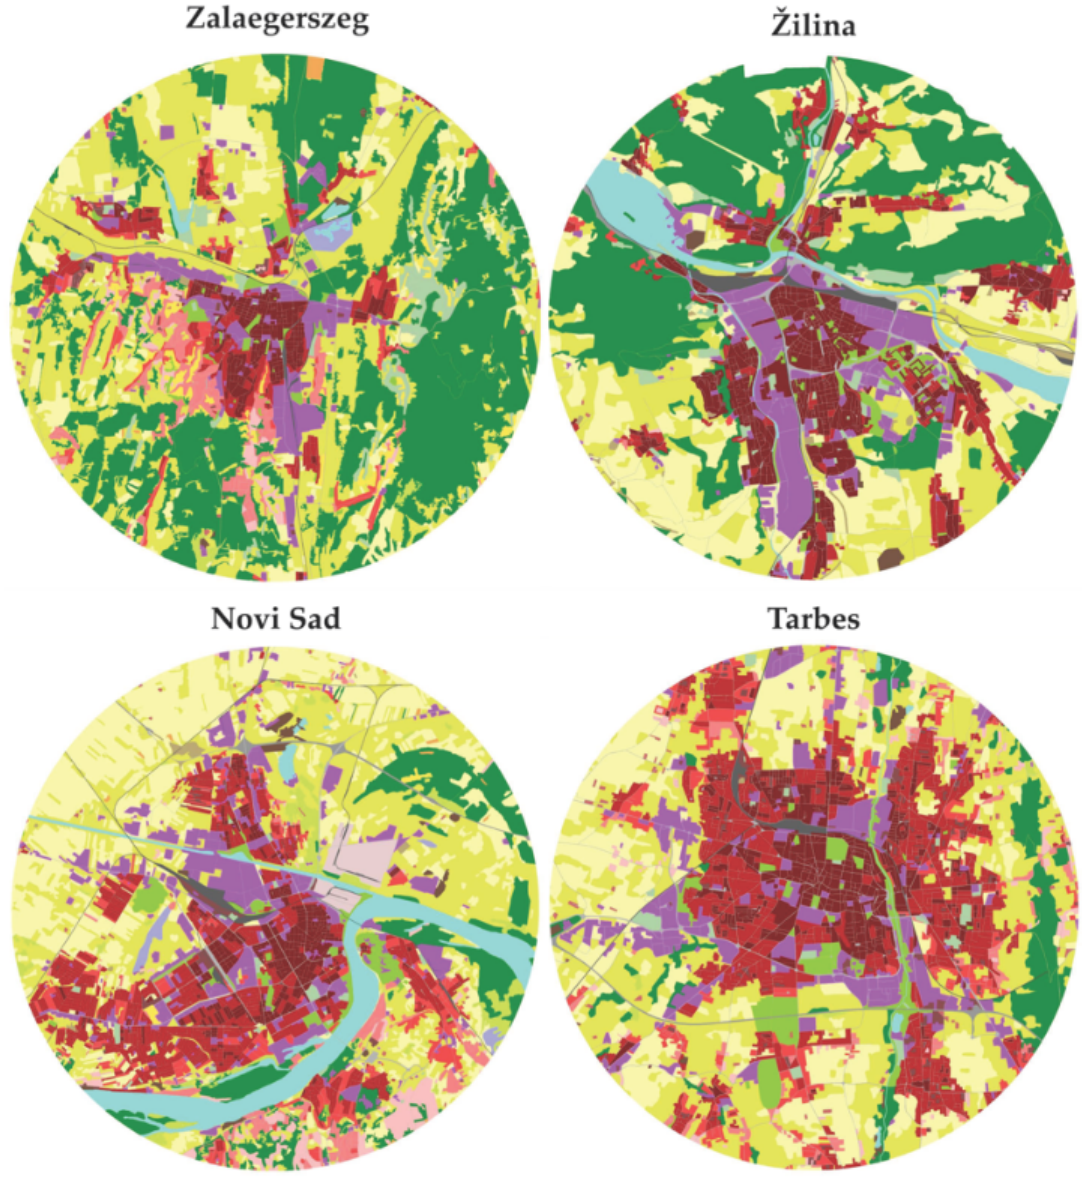
Figure 8. Interesting look-alike city pairs. (Source: [29], final validation Zalaegerszeg 29 June 2018, Žilina